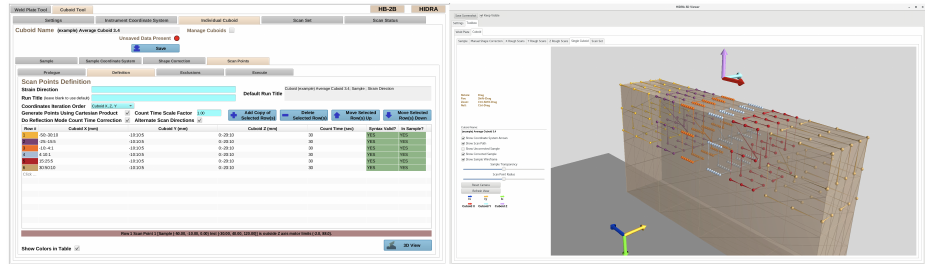
Figure 4. Screenshot of the cuboid